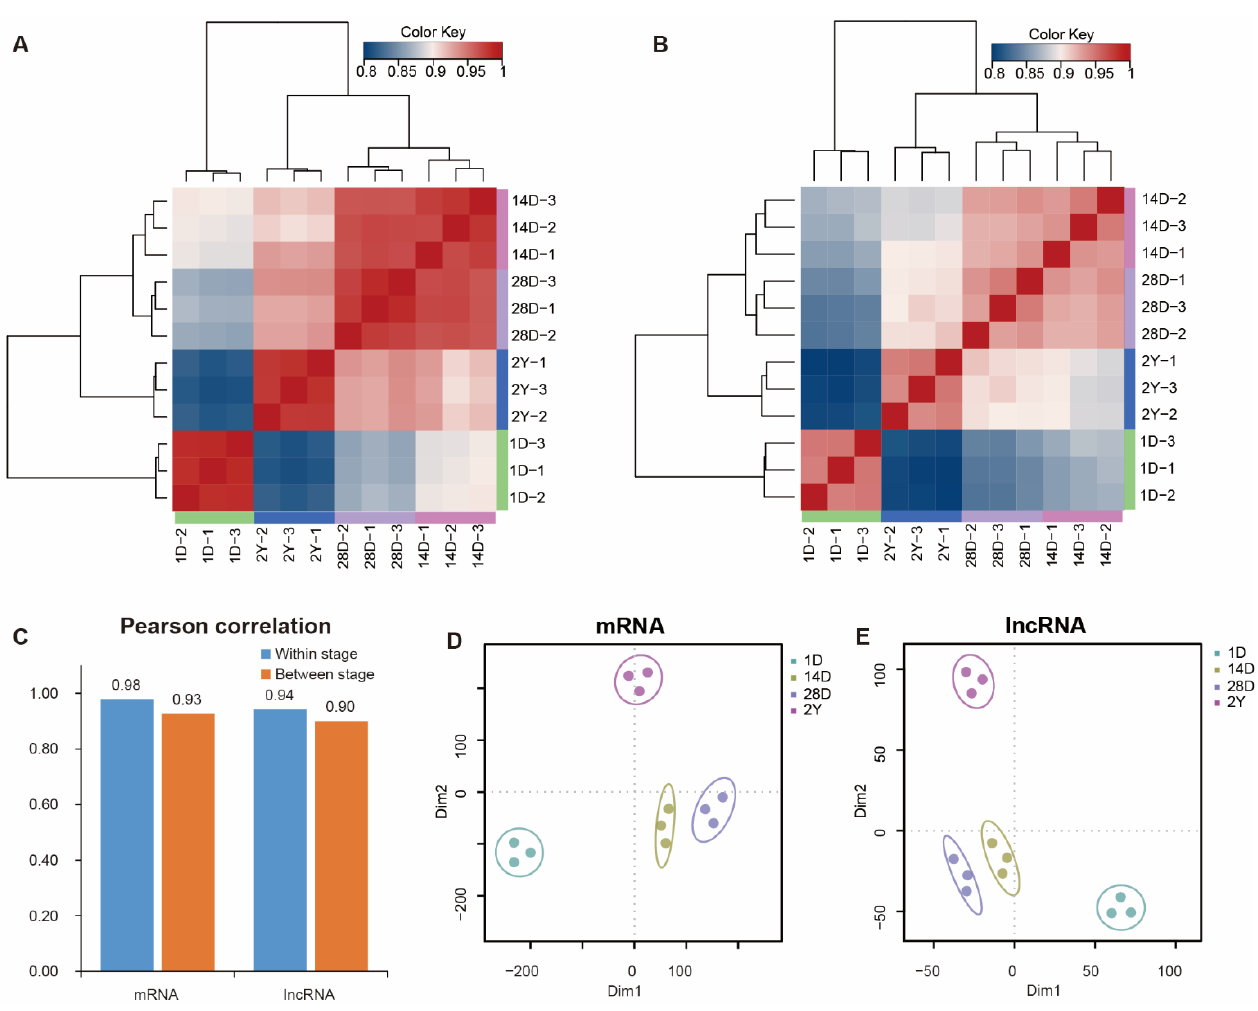
Figure 2. The Pearson ’s correlation matrices and t-SNE analysis. ( A , B ) The mRNA ( A ) and lncRNA ( B ) correlation matrices for all samples, and the top and left panels show the sample trees based on the Pearson ’s correlation. ( C ) The average correlation coefficients of mRNAs and lncRNAs between stages and within stages. ( D , E ) A two-way t-SNE plot of mRNAs ( D ) and lncRNAs ( E ) is shown based on expression profiles.